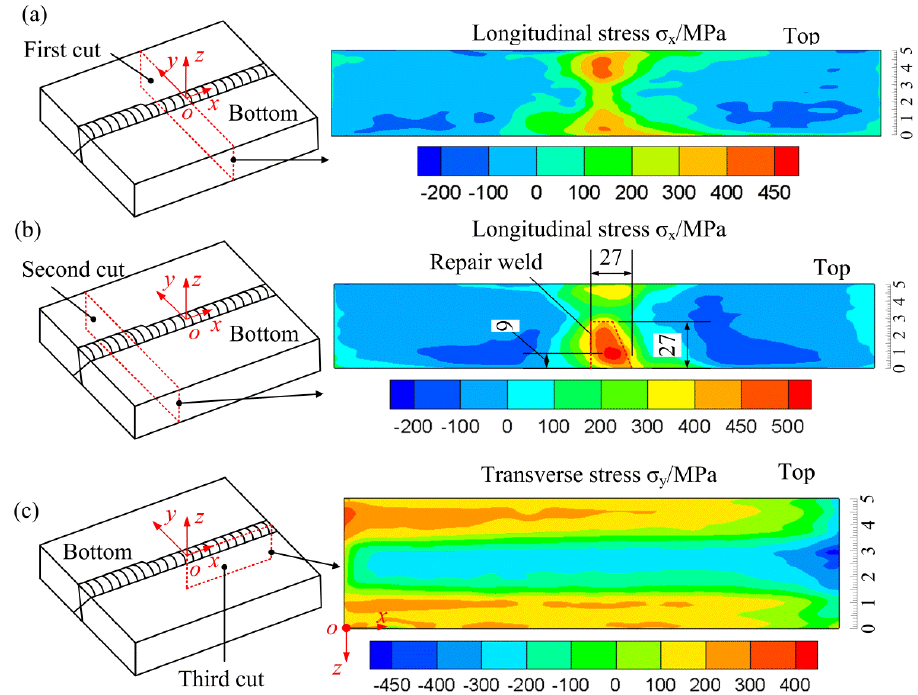
Figure 6. Stress distributions along the three cut planes. ( a ) Longitudinal stress along the plane of the first cut; ( b ) longitudinal stress along the plane of the second cut; ( c ) transverse stress along the plane of the third cut plane.